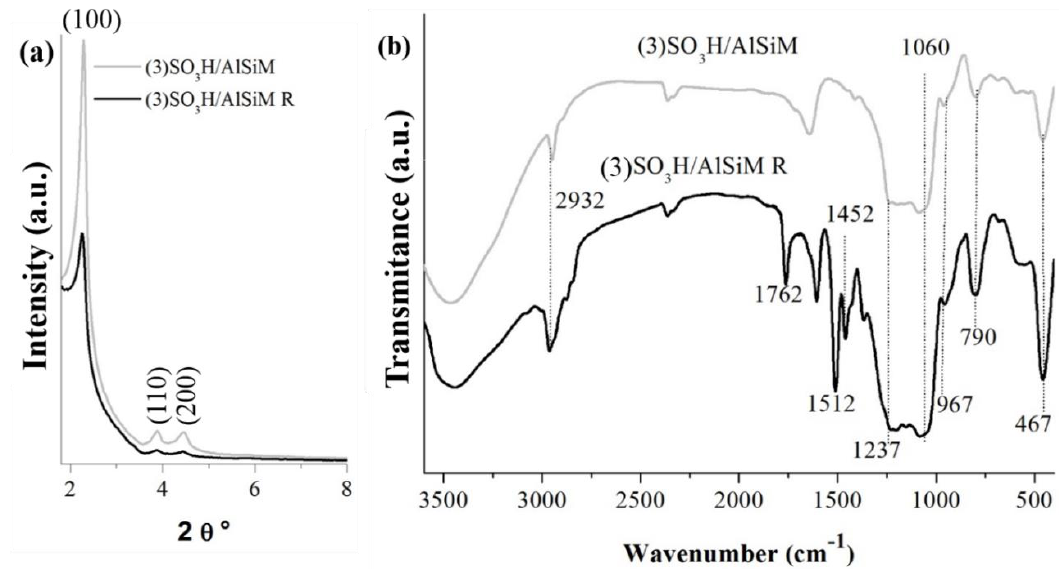
Figure 12. ( a ) Comparison of new catalyst XRD standards, (3)SO 3 H / AlSiM and after reuse, (3)SO 3 H / AlSiM R; ( b ) Comparison of new catalyst FTIR spectra, (3)SO 3 H / AlSiM, and after reuse (3)SO 3 H / AlSiM R.